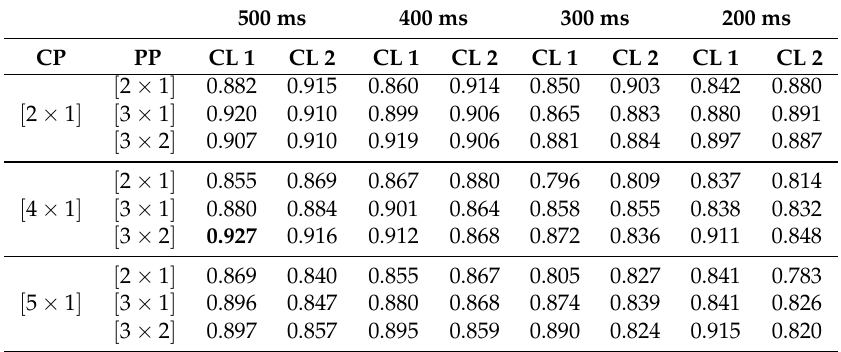
Table 2. Summarized results for the 18 convolutional neural networks (CNN) structures for all considered trial lengths with fixed convolution patches. PP = pool patch, CP= convolution patch, CL= convolution layers.